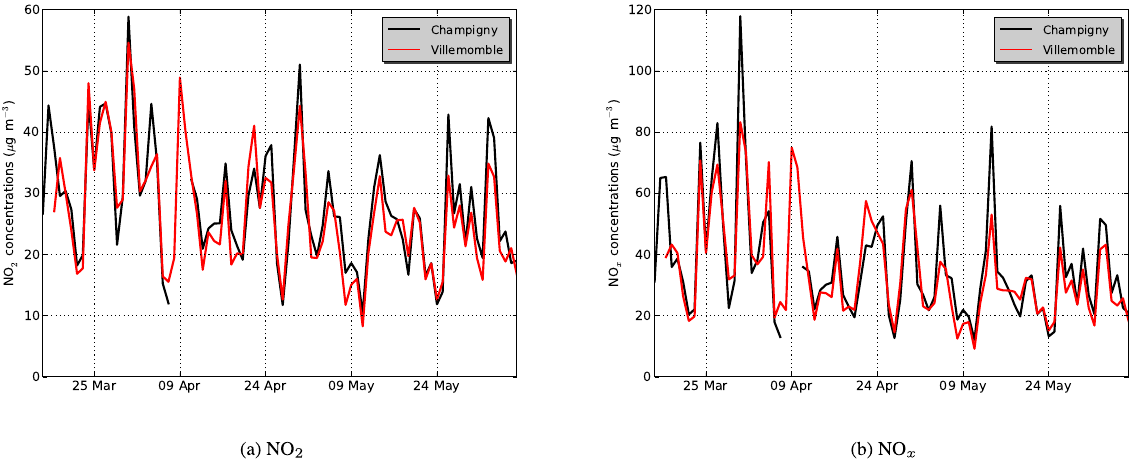
Figure 9. Comparison of the daily-averaged measurements at the two air monitoring stations for (a) NO 2 and (b) NO x . The first station is located 5km from the modeling area (Champigny) and the second station is located 7km from the modeling area (Villemomble).